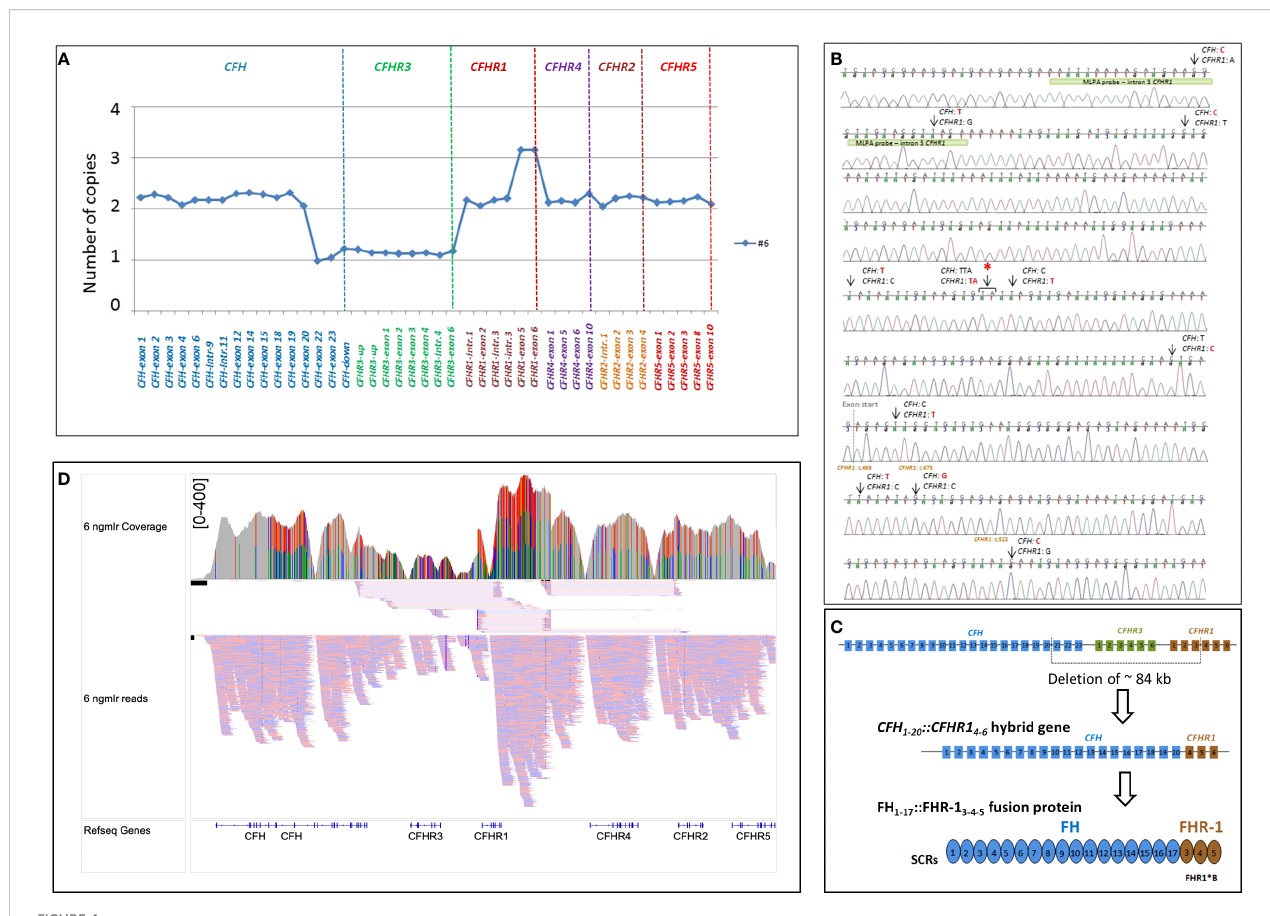
FIGURE 4 Identi fi cation of CFH 1-20 ::CFHR1 4-6 hybrid gene in patient #6. (A) The abnormal MLPA pattern found in patient #6 involves CFH , CFHR3 and CFHR1 genes. It results in: 1) loss of one copy of exons 22-23 of CFH; 2) loss of 1 copy of the entire CFHR3 gene; 3) 2 copies of intron 1-2 and 3 of CFHR1 ; 4) 3 copies of exon 5 and 6 of CFHR1. (B) Electropherogram including the sequence of the genomic breakpoint. Arrows indicate the nucleotide differences between CFH and CFHR1. The fi rst part of the sequence corresponded to CFH; the red asterisk indicates the genomic position where the intron 4 CFHR1 sequence started. Four nucleotide differences were found in exon 4 CFHR1: c.469, c.475, c.523 (indicated in brown) and c.588 (not reported). Three of them led to three FHR-1 amino acid changes (p.Tyr157-Val159-Gln175, respectively) and are characteristic of the basic isoform of CFHR1 (CFHR1*B ). The green bar highlights the target sequence of the “ CFHR1 -intron 3 ” probe, located in intron 3 of CFHR1 ( 194 nucleotides before exon 4), upstream of the breakpoint region, explaining the 2 copies identi fi ed by this probe. (C) Representation of ~84 kb deletion involving CFH , CFHR3 and CFHR1 , resulting in the generation of CFH 1-20 ::CFHR1 4-6 hybrid gene that encodes the FH 1-17 ::FHR1 3-5 fusion protein. (D) Screenshot from IGV (Integrative Genomics Viewer) showing reads from SMRT sequencing. SMRT sequencing identi fi ed both CFH 1-20 ::CFHR1 4-6 hybrid gene and the CFHR1 duplication. Misaligned reads in the CFHR1-CFHR4 intragenic region and the CFHR2 are also